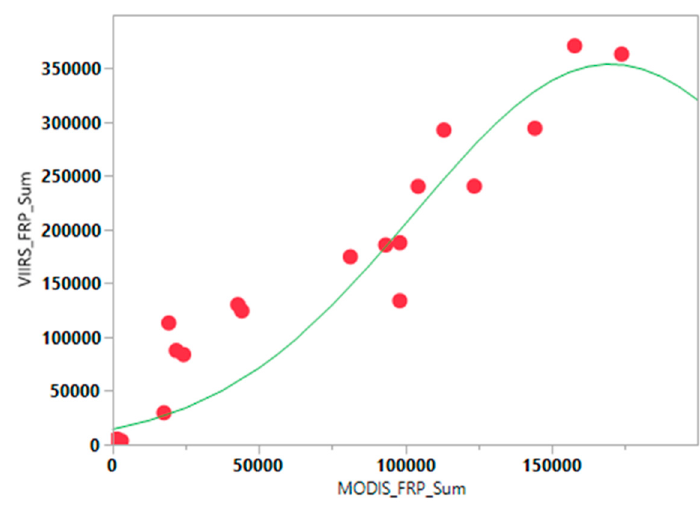
Figure 9 . Gaussian fit of MODIS sum of FRP data and VIIRS data. The results from the fit were used to estimate TPM emissions from 2003–2016.